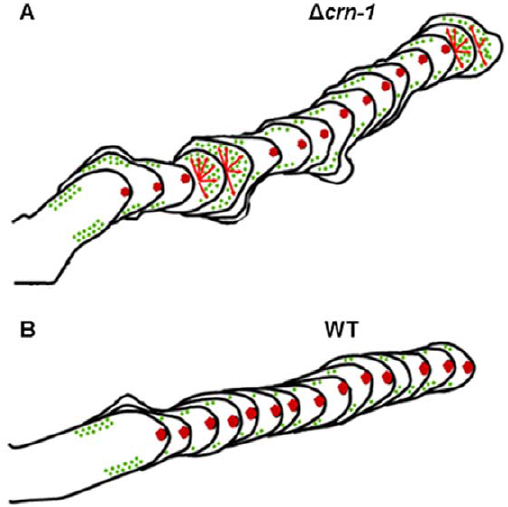
Figure 11. Reconstructions of morphogenetic sequences from time lapse movies of the D crn-1 mutant and the WT strain; the mutant shows a lack of directionality and temporal loss of polarized growth, the green dots show the places of endocytic patches and how they are misplaced in the mutant when the Spk is not present, the small arrows show the shifts between polarized growth and isotropic growth.